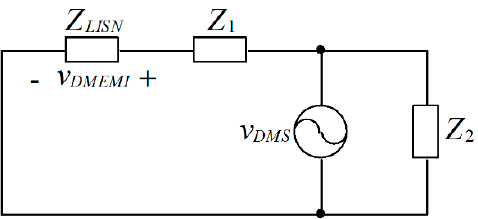
Figure 2. DM equivalent circuit model of a single-phase shunt APF.